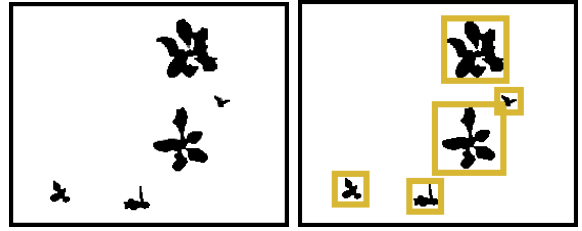
Figure 3. Blob selection from connected